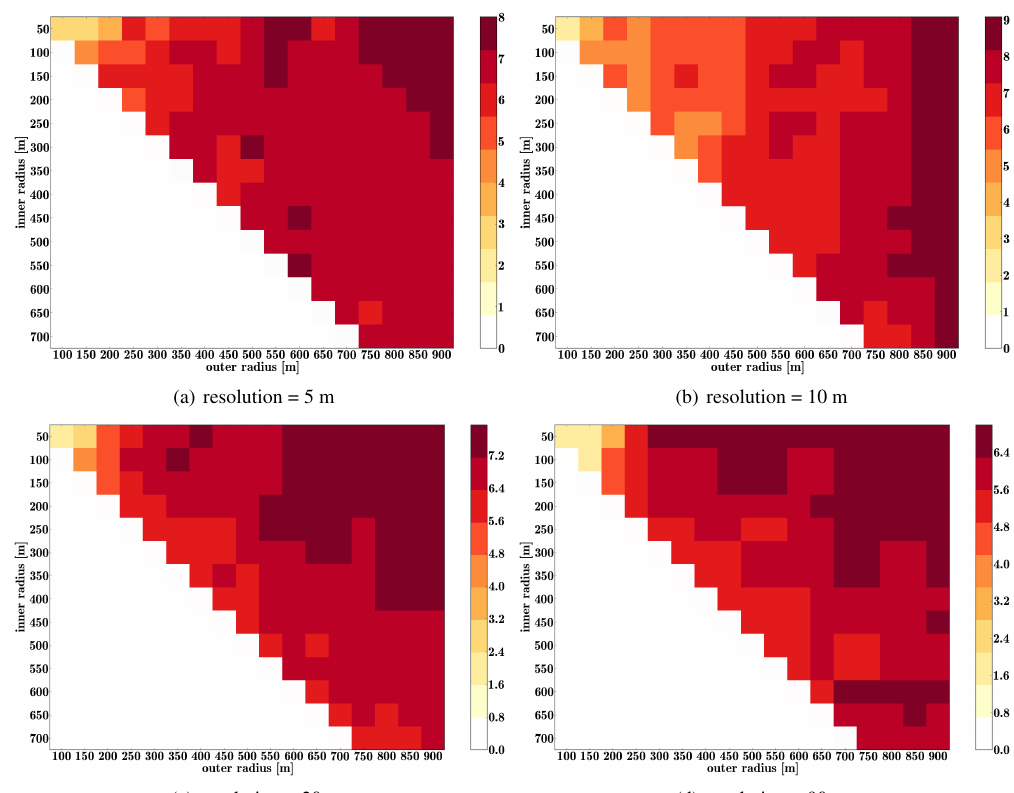
Figure 5: Claim Rate Difference Class 1 - Class 6 for different